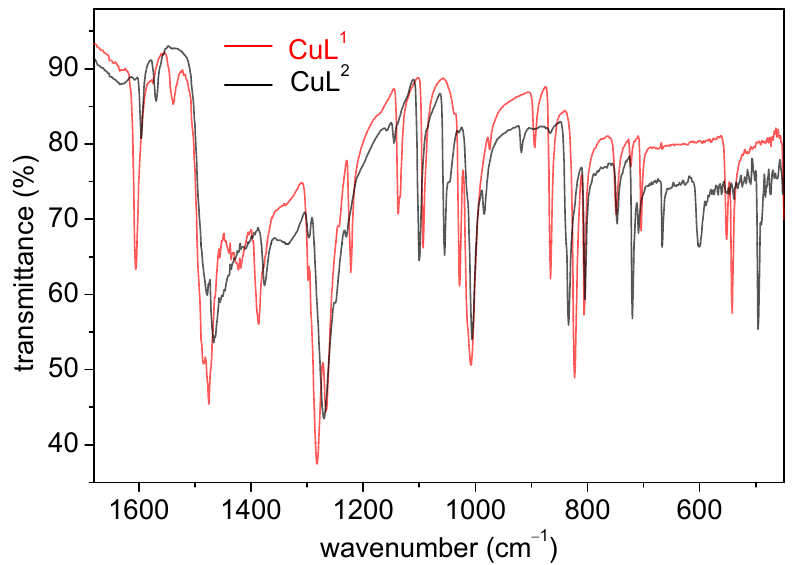
Figure 4. FT ‐ IR spectra of the complexes CuL 1 (L 1 = 2 ‐ bromo ‐ 5 ‐ methylpyridine) (red) and CuL 2 (L 2 = 2 ‐ bromo ‐ 4 ‐ methylpyridine